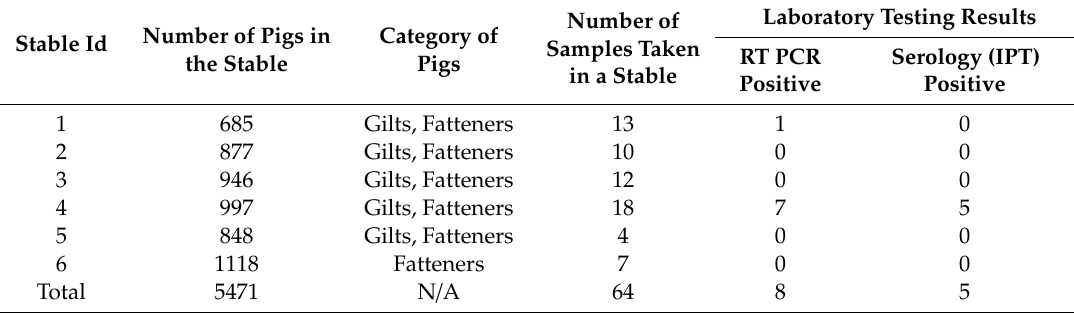
Table 3. RT PCR and serology results of pigs sampled before culling in di ff erent stables of Farm B at location